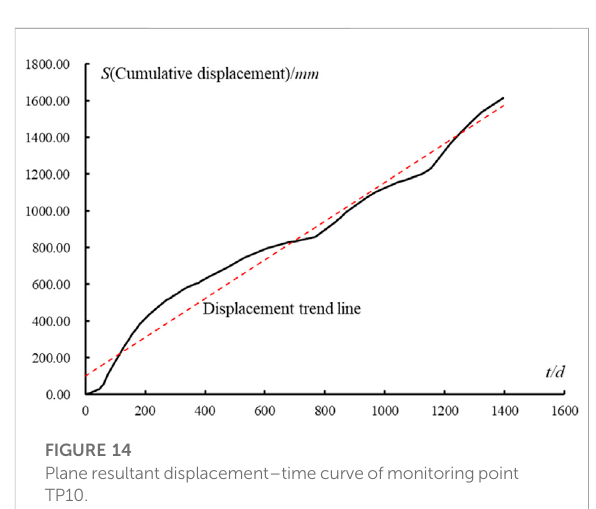
FIGURE 15 Displacement rate time curve of monitoring point